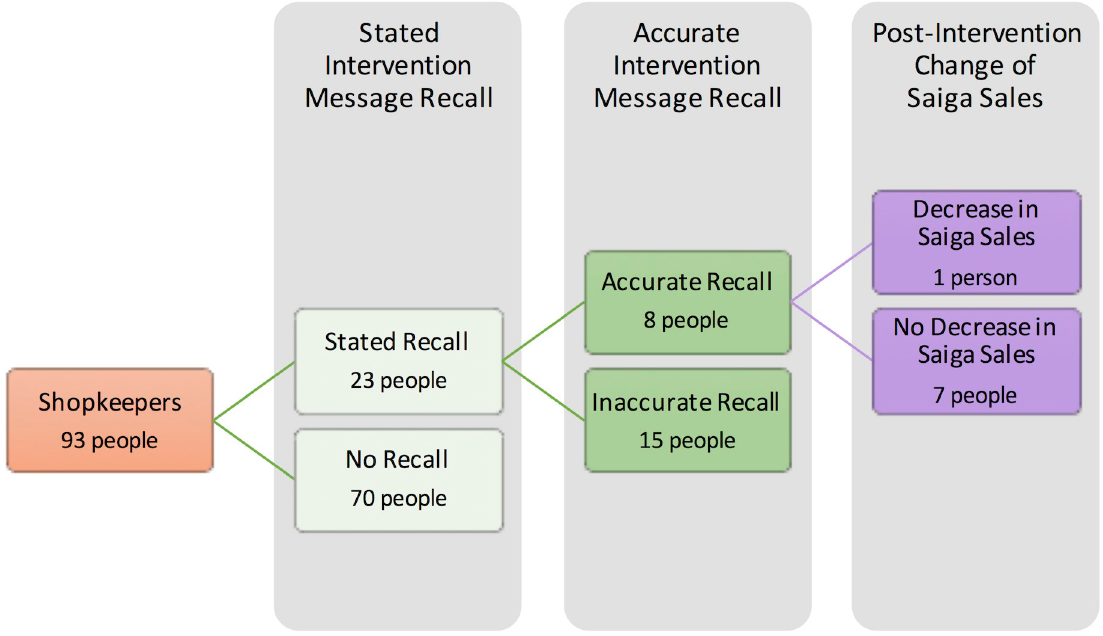
Fig 6. A funnel of shopkeeper respondents from the total respondent pool through till perceived decrease in saiga sales following the intervention. Colours correspond to the Theory of Change stages outlined in Fig 1.